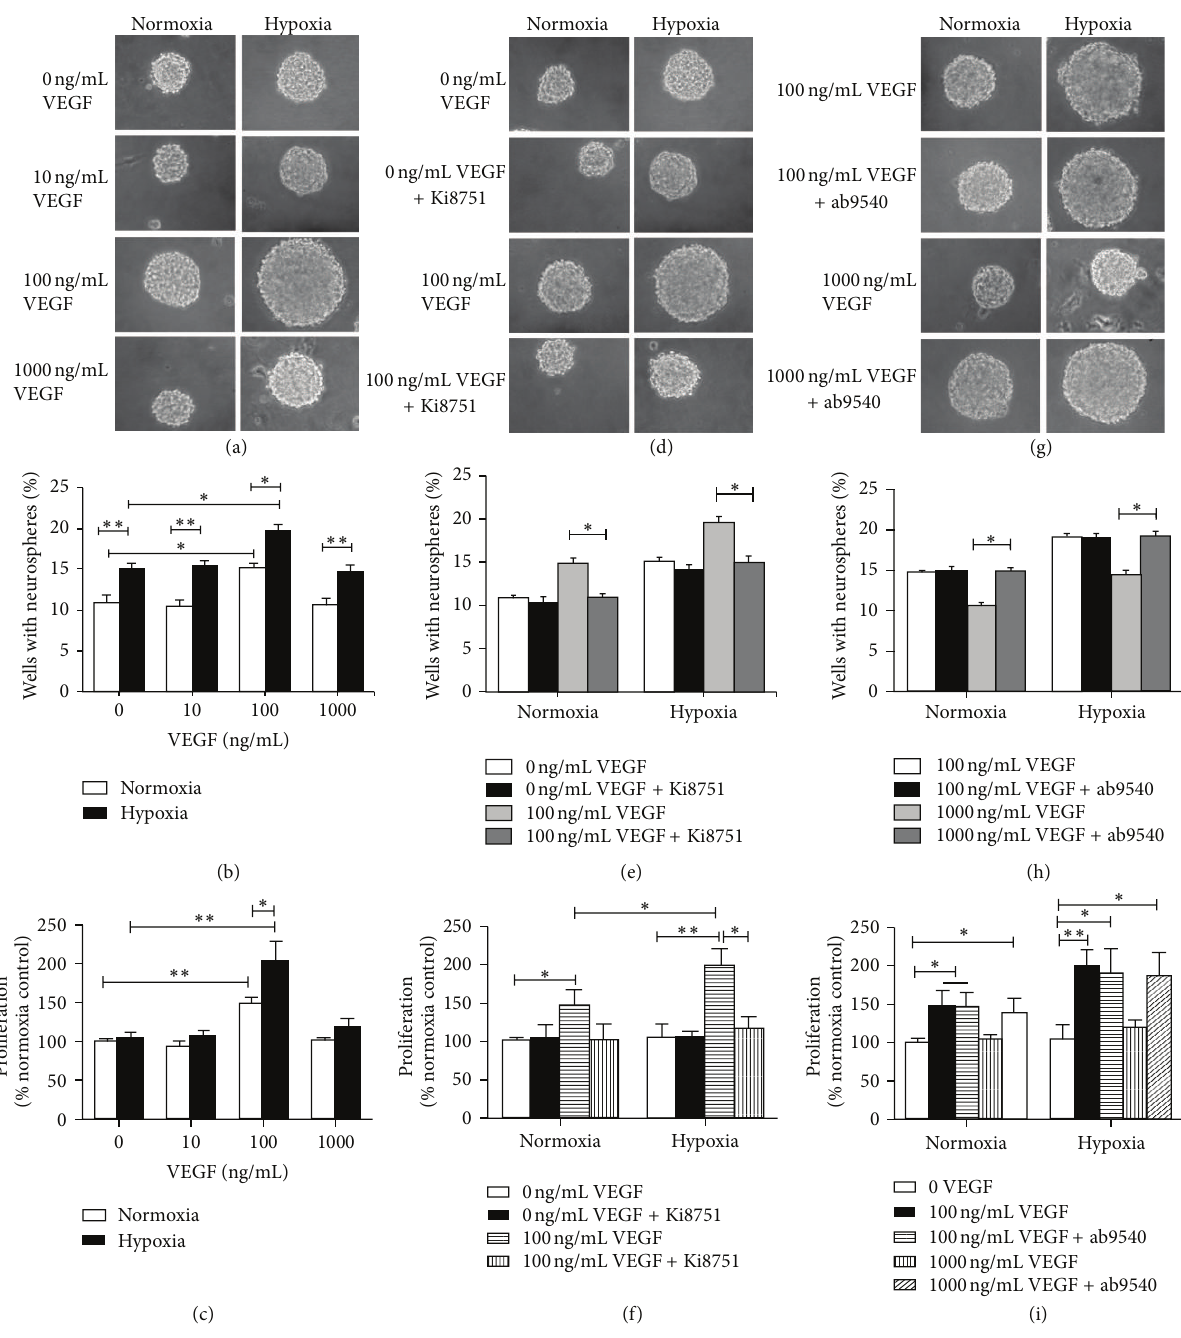
Figure 2: Effect of VEGF on GBSCs proliferation. GBSCs were treated with indicated concentration of VEGF in the presence or absence of VEGFR inhibitors, followed by Neural Colony-Forming Cell Assay and cell viability analysis using ATP assay. (a)–(c) dose effect of VEGF on GBSCs proliferation. (d)–(f) effect of VEGFR2 inhibition on GBSCs proliferation. (g)–(i) effect of VEGFR1 inhibition on GBSCs proliferation. Panels (a), (d), and (g) representative images of neurospheres formed in neurosphere formation assays. Panels (b), (e), and (h) GBSC proliferation was tested using a Neural Colony-Forming Cell Assay; all data are represented as the percent of wells with neurospheres. Panels (c), (f), and (i) GBSCs proliferation was tested using ATP assay; all data are represented as a percentage of the normoxia control. The statistical significance in comparisons between the different groups is indicated using the capped lines ( ∗ 𝑃 < 0.05 , ∗∗ 𝑃 < 0.01